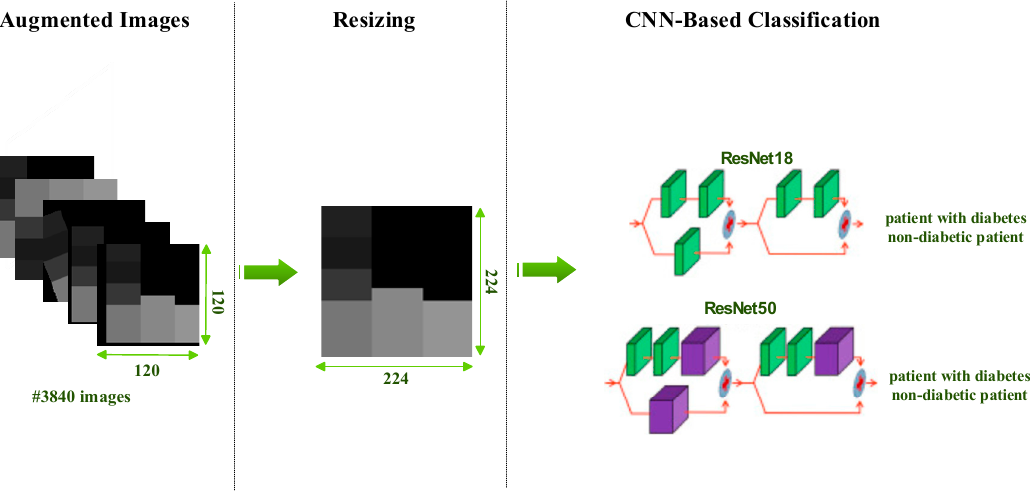
Figure 6. Classification of diabetes images as diabetic (1) and nondiabetic (0) with ResNet models.